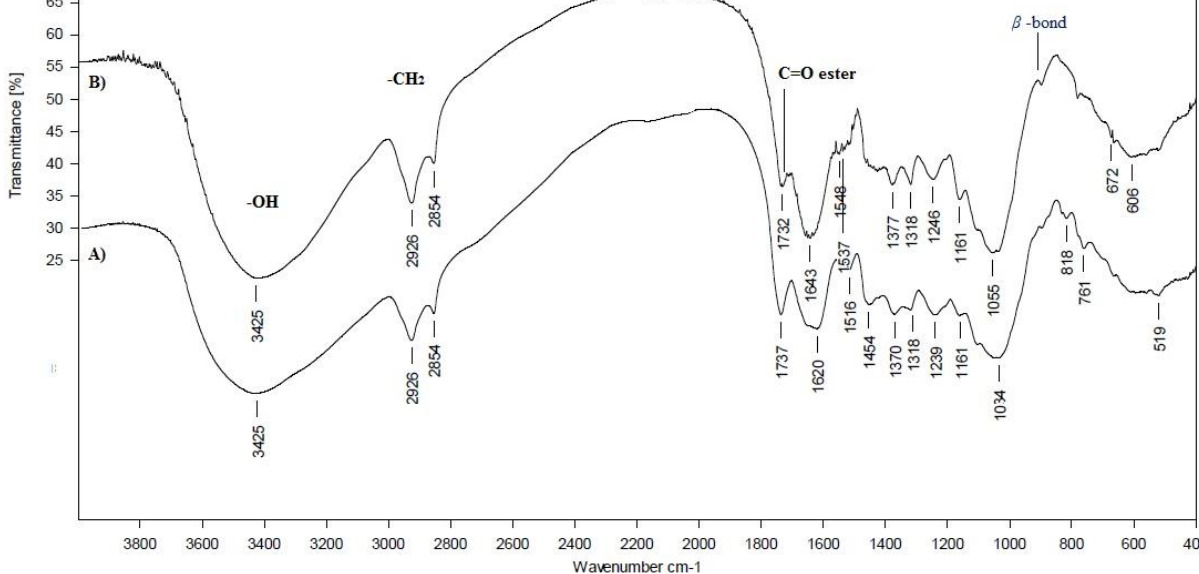
Figure 7. FTIR spectra of hexane extracted rose flowers (HERF) substrate (A) and mycelium HERF - based bio - composite (B). Table 4. Bands assignment for the FTIR characterization of hexane extracted rose flowers (HERF), steam distilled lavender straw (SDLS) and mycelium HERF/SDLS - based bio - composite.